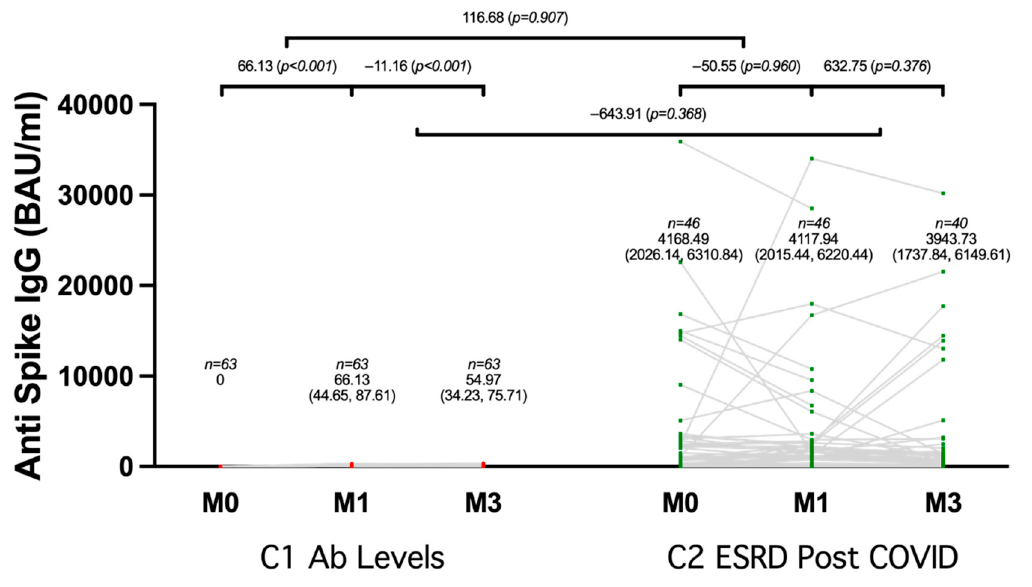
Figure 1. Changes in anti-spike IgG in 109 ESRD patients, including 63 who received the first dose of a two-dose regimen of ChAdOx1 nCoV-19, and 46 who recovered from COVID-19, were assessed at baseline (M0), 1 month, and 3 months. BAU stands for binding antibody units, and IgG stands for immunoglobulin